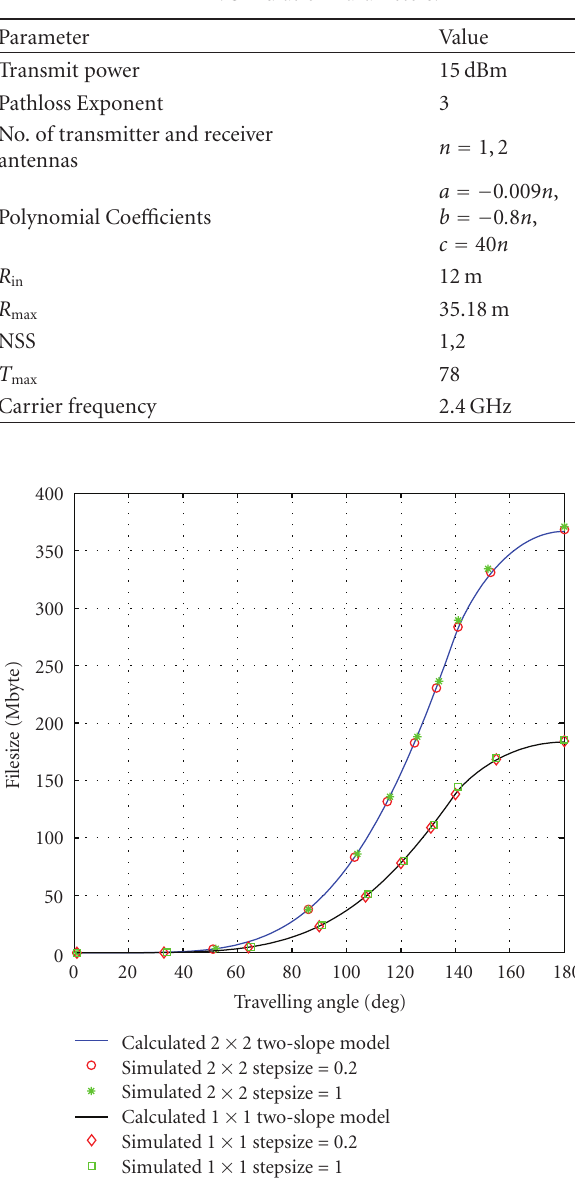
Figure 4: Comparison between simulation and theoretically com- puted results for two-slope throughput-distance model.